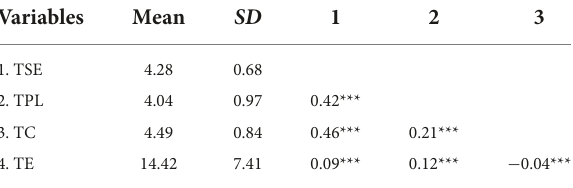
TABLE 1 Descriptive statistics and correlations of the main study